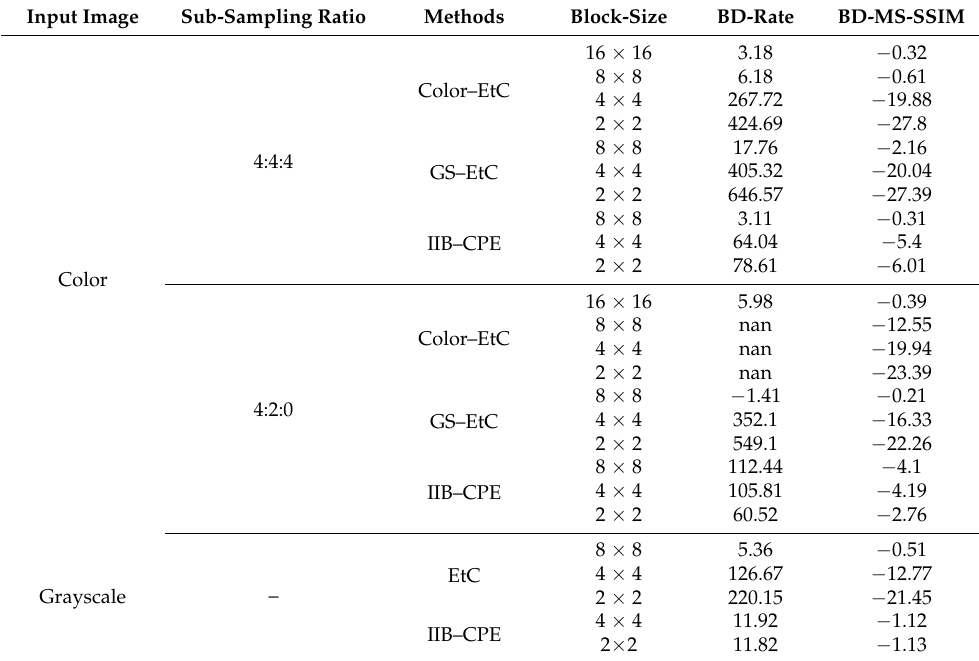
Table 1. The JPEG compression performance on different perceptual encryption methods in terms of Bjøndegaard Delta measures. The rate differences are for the equivalent quality relative to the JPEG under MS–SSIM for RD curves plotted in Figures